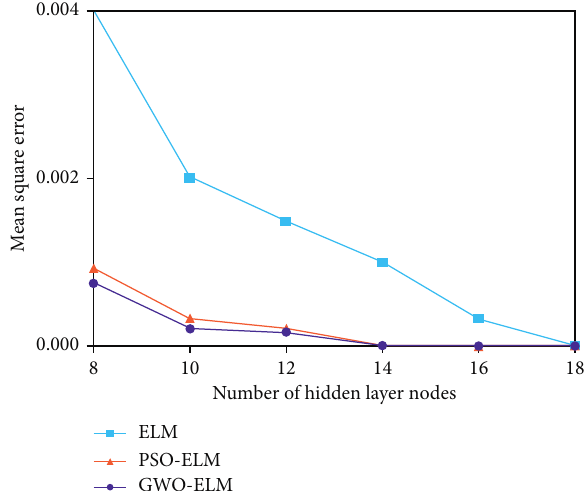
Figure 3: The relationship between the mean square error of the sample and the number of nodes in the hidden layer.